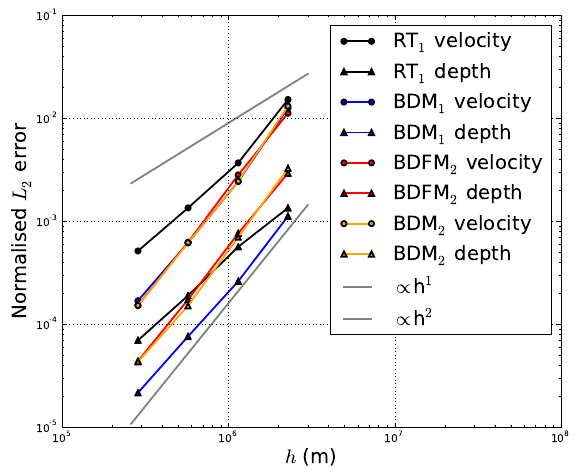
Fig. 13. Rigid rotation nonlinear shallow water test case on the sphere: L 2 -error of the velocity u and depth D fields versus mesh size h . 3612